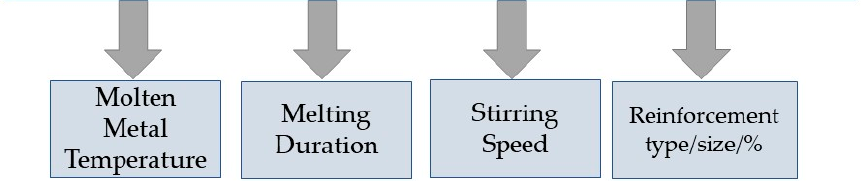
Figure 6. Factors that influence the stir casting process.